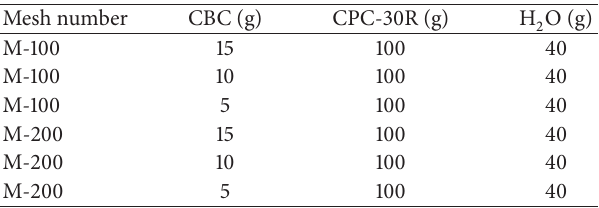
Figure 2: System hot insolated plate technique.